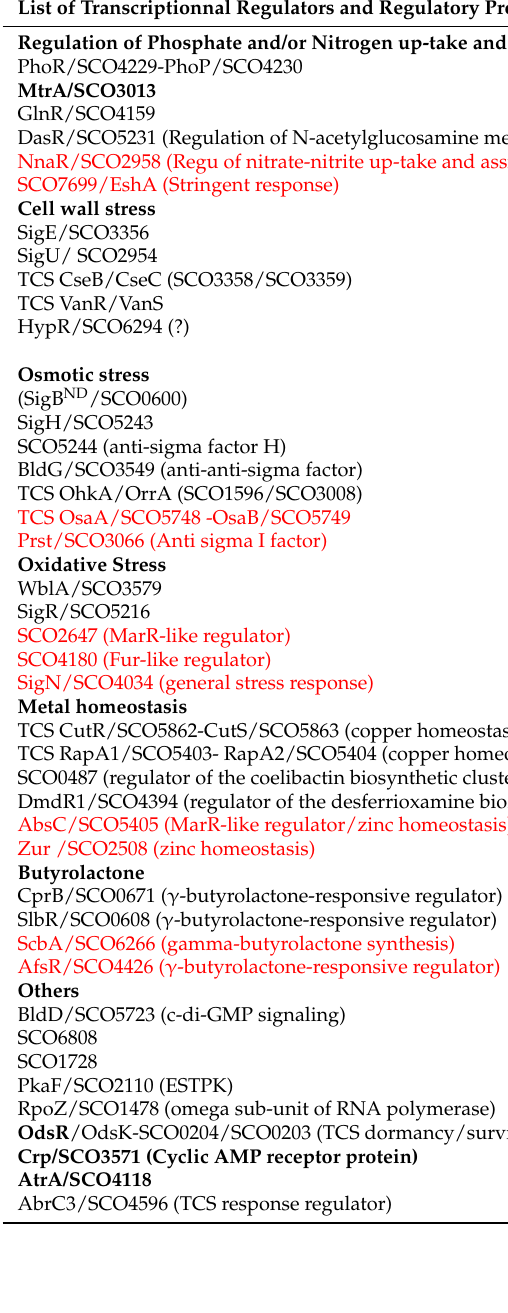
Table 1. List of the 71 transcriptional regulators and 23 eukaryotic-like protein kinases detected in our study and classified, when possible, according to their role in the regulation of phosphate and/or nitrogen up-take and assimilation (6), in cell wall (5), osmotic (8), and oxidative (5) stress responses, in metal homeostasis (6), butyrolactone response (4), and others processes (38). Regulators are either known to have a positive (Pos) or negative (Neg) impact on ACT biosynthesis or a predictable one (Neg or Pos within brackets followed by a question mark) or an unknown one (question mark). Regulators in black are those that were more abundant in SC than in SL , whereas regulators in red are those that were more abundant in SL than in SC . The numbers within brackets are referring to publications demonstrating the positive or negative regulatory role played by each transcriptional regulator in the regulation of ACT biosynthesis. Regulators in bold are those that were shown to interact directly with the promoter region of actII-ORF4 which encodes the specific activator of the ACT cluster. (SigB/SCO0600) is within brackets since it is known to be involved in osmotic stress response and to have impact on ACT biosynthesis, but it was not detected in our